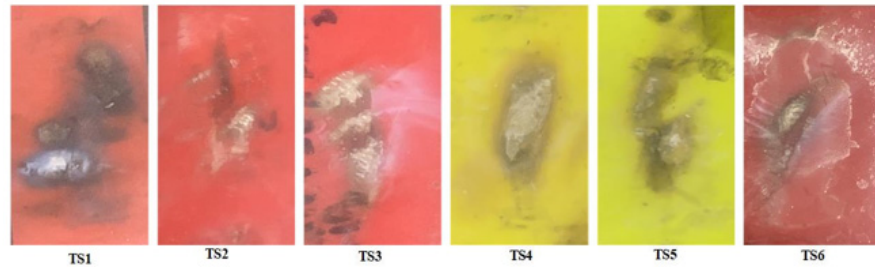
Figure 4. Tracking and erosion pattern of the unaged samples.